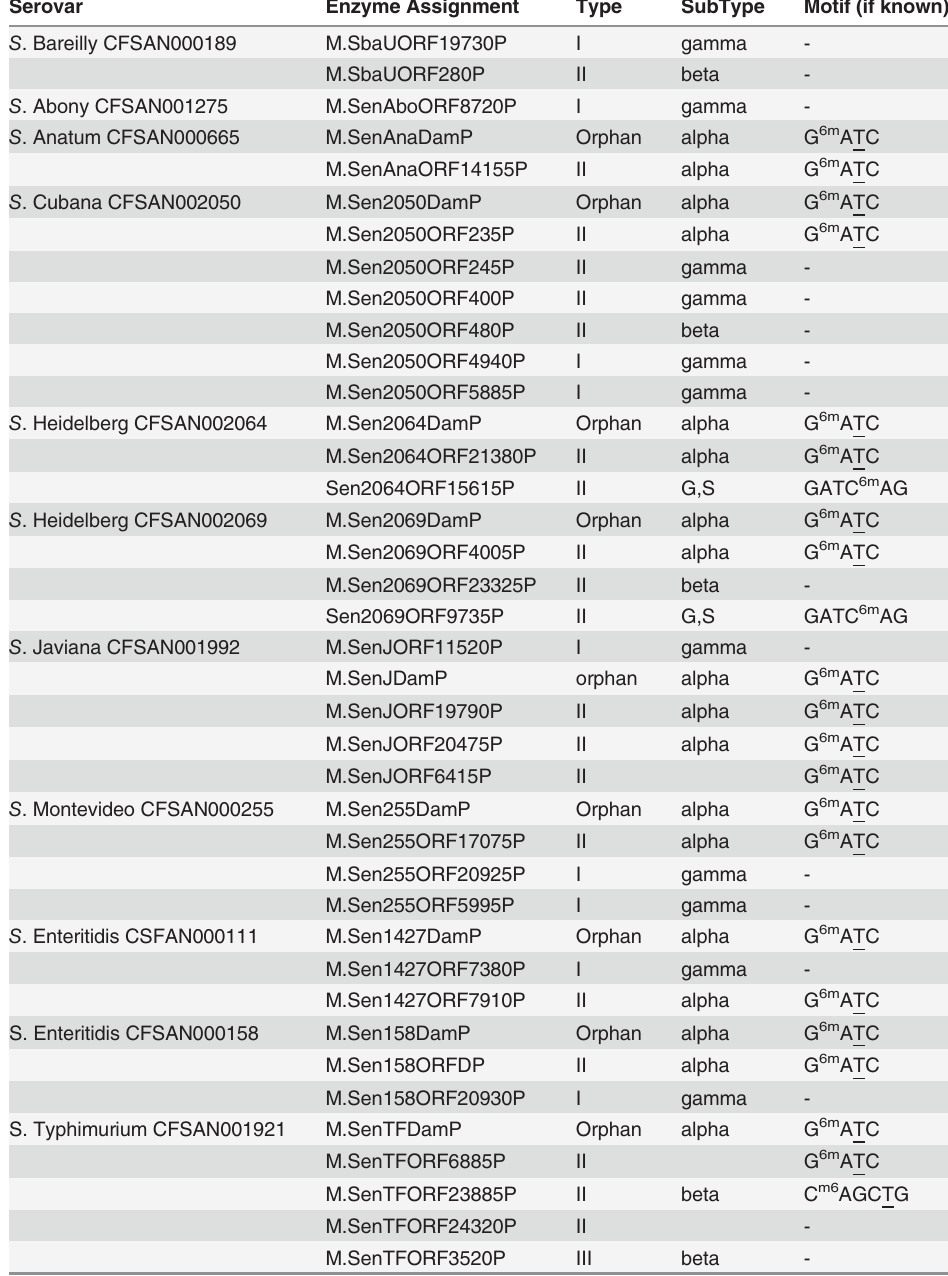
Table 3. Methyltransferases identified in the Salmonella serovars, but not assigned to a motif. Serovar Enzyme